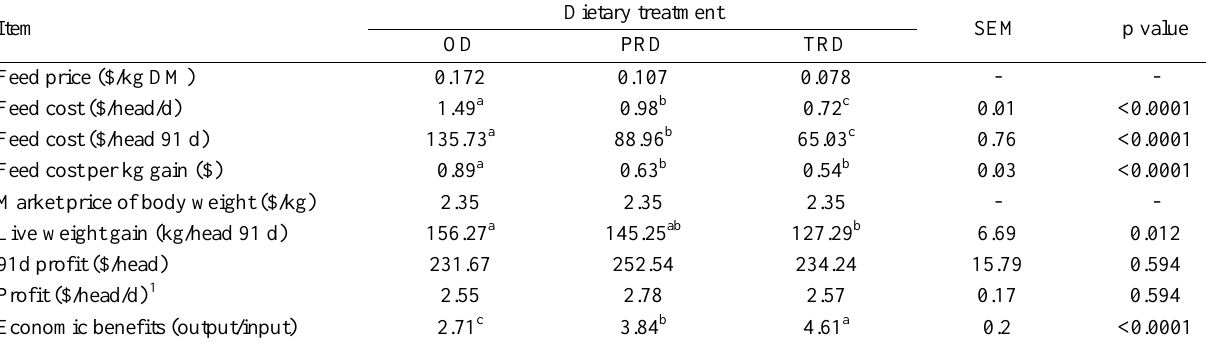
Table 5. Economics of partial or total replacement of maize with alternative feed sources